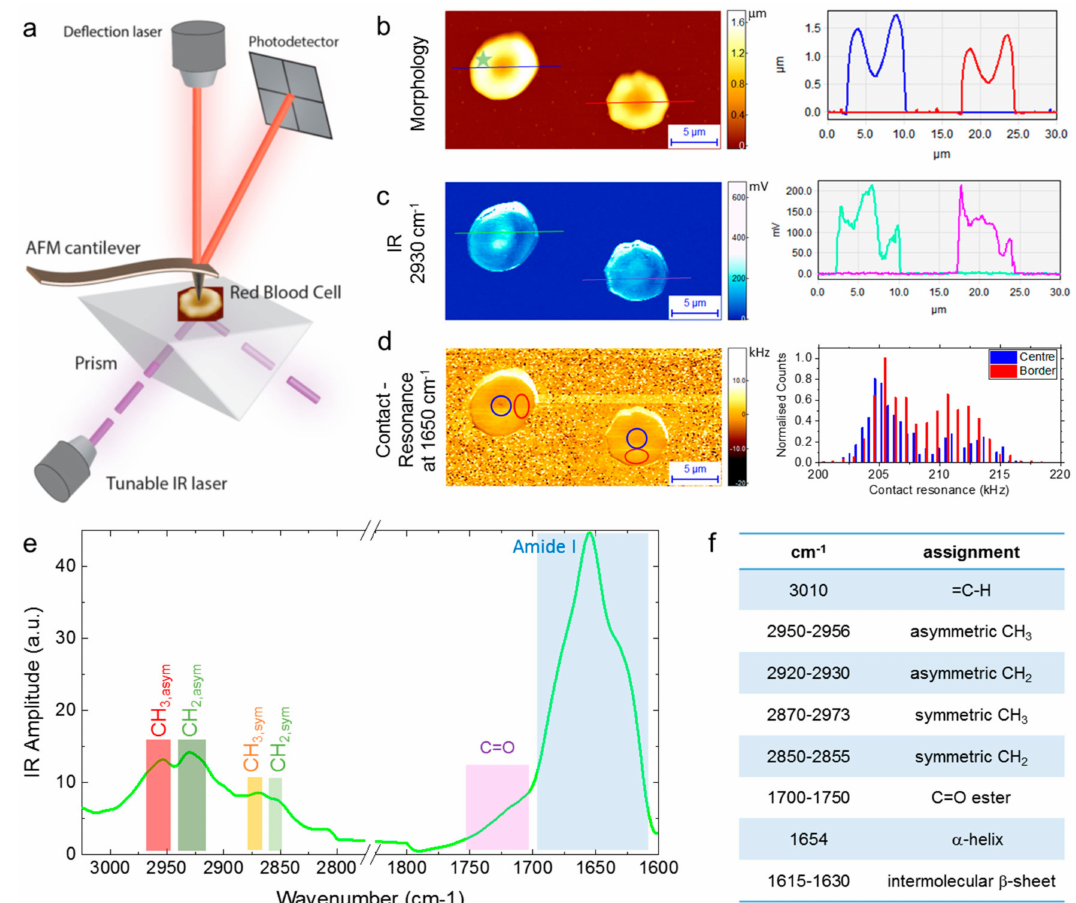
Figure 1. Infrared nanospectroscopy measurements of RBCs. ( a ) Schematic representation of the AFM-IR setup that enables the simultaneous acquisition of: 3-D ( b ) morphology map, with examples of cross-sectional height of the cells; ( c ) chemical map at 1650 cm − 1 , with examples of cross-sections of IR absorption of the cells acquired at the locations indicated by the light blue and pink lines; and ( d ) cantilever contact-resonance maps of individual cells, which are monotonically related to the cell stiffness; the histogram on the right represents the distribution of values of the tip-sample contact resonance within the red (border) and blue (centre) circles within the cells. ( e ) After acquisition of the maps is completed, the AFM tip can be positioned (green star in panel b) with nanoscale resolution ( ≈ 20–50 nm) on the cell to acquire an IR spectrum, averaged from 5 independent spectra. ( f ) We focused our spectroscopic investigation in the IR lipid region (2800–3050 cm − 1 ) and amide band I, related to the secondary and quaternary structural conformation of